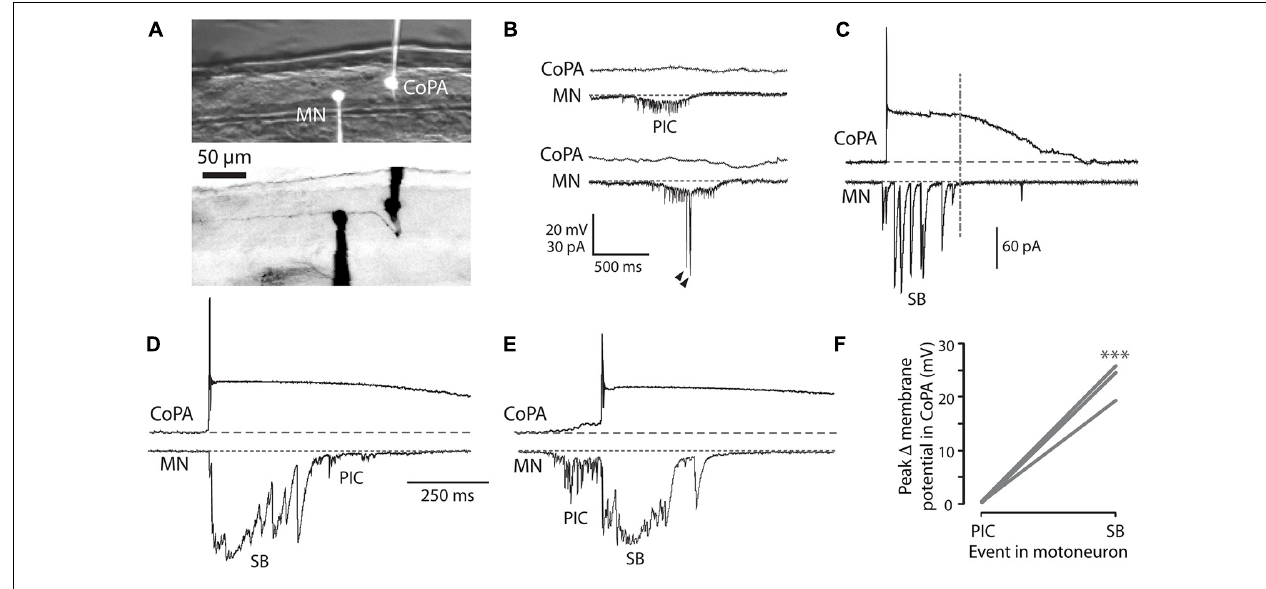
line. Arrowheads in MN trace denote large glutamatergic peaks. (C) Depolarizing glycinergic events in CoPAs coincide with glycinergic synaptic bursts (SBs) in ipsilateral MNs during a spontaneous fictive contralateral single coil. Scale same as in (B) but note different vertical scale for MN trace. A vertical dashed line marks the end of the SB in the MN trace. (D) A depolarizing glycinergic event in a CoPA during a spontaneous fictive double coil (synaptic burst, SB, followed by PIC) in a MN resembles the activity seen during a single coil and coincides with the glycinergic portion of the mixed event in the MN. Scale same as in (C) but note different time scale. (E) Same conditions as (D) but here for a fictive double coil beginning on the ipsilateral side (PIC preceding SB). All recordings are from the same pair of neurons pictured in (A) . (F) Comparison of the average change in membrane potential for CoPAs during each type of activity in the MN ( ∗∗∗ p < 0.001; Mann-Whitney U -test for each neuron between event